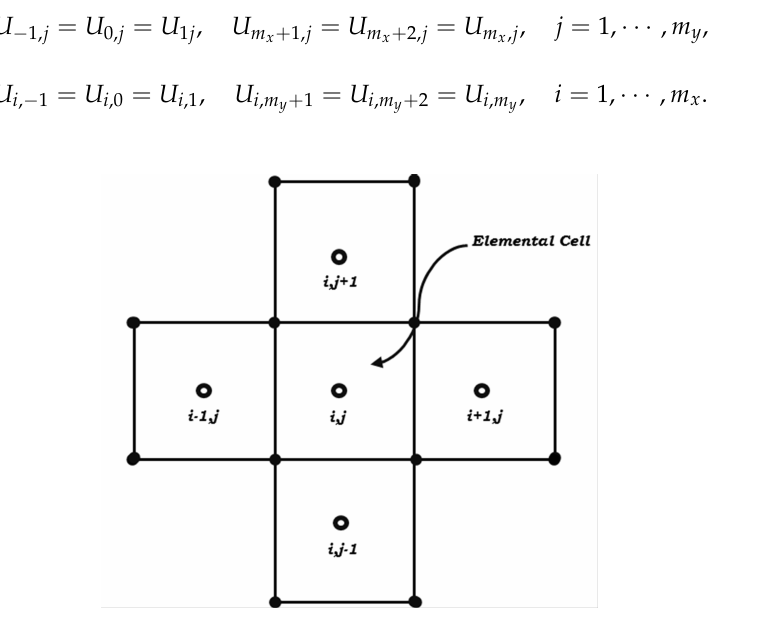
Figure 2. Nodal indexing of elementary cells for the structured